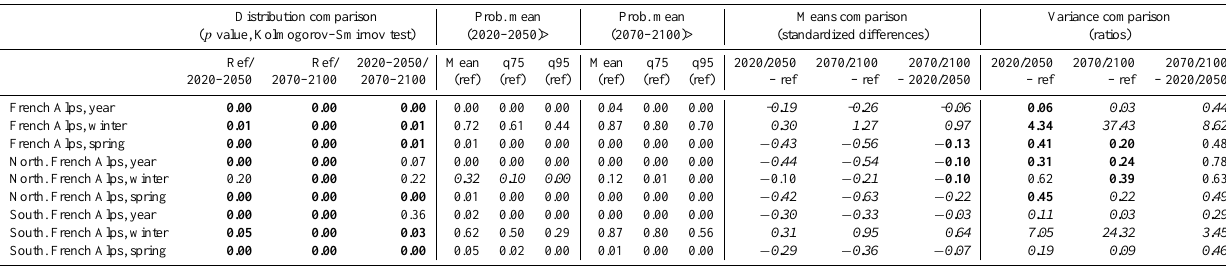
Table 6. Changes in CI models between the reference period and the two future periods. “Ref”, 2020–2050 and 2070–2100 correspond, respectively, to the three considered periods – the reference period (1960–1990) and the middle and end of the 21st century. Details of the table are the same as for Table 5.